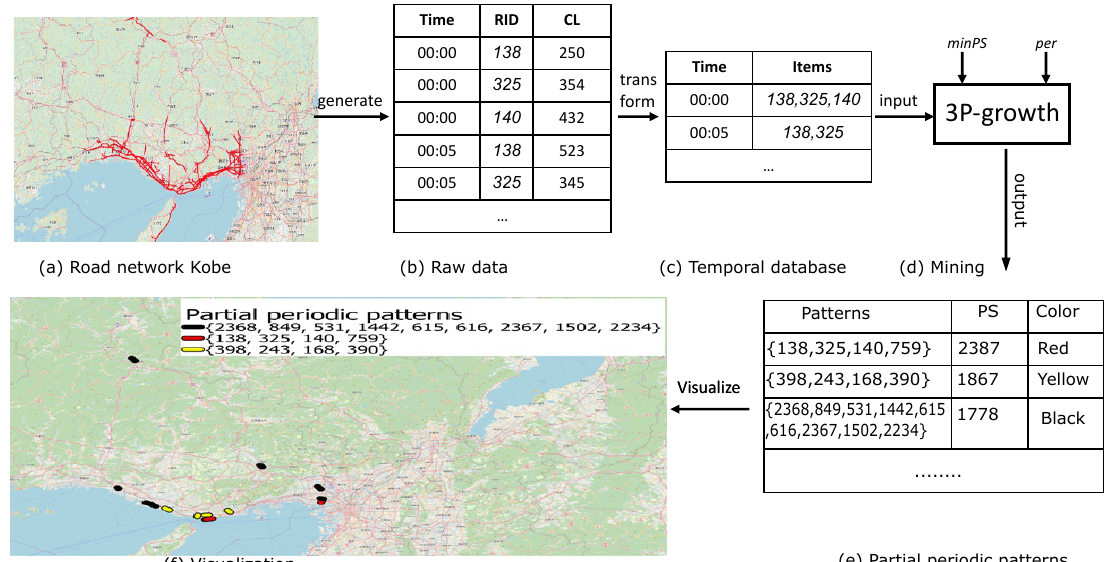
Figure 10. Congestion data analytics ( a – f ). The terms RID and CL stand for road identifier and congestion length,